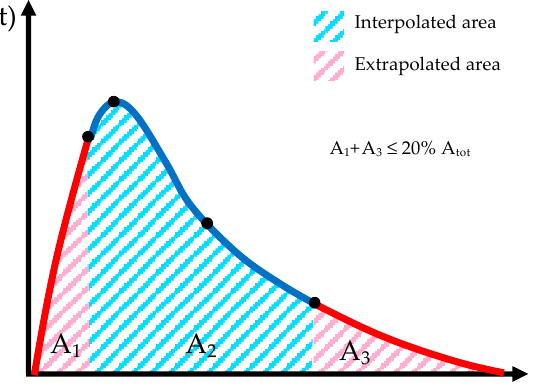
Figure 2. Time–activity curve (TAC) with interpolation and extrapolation areas.